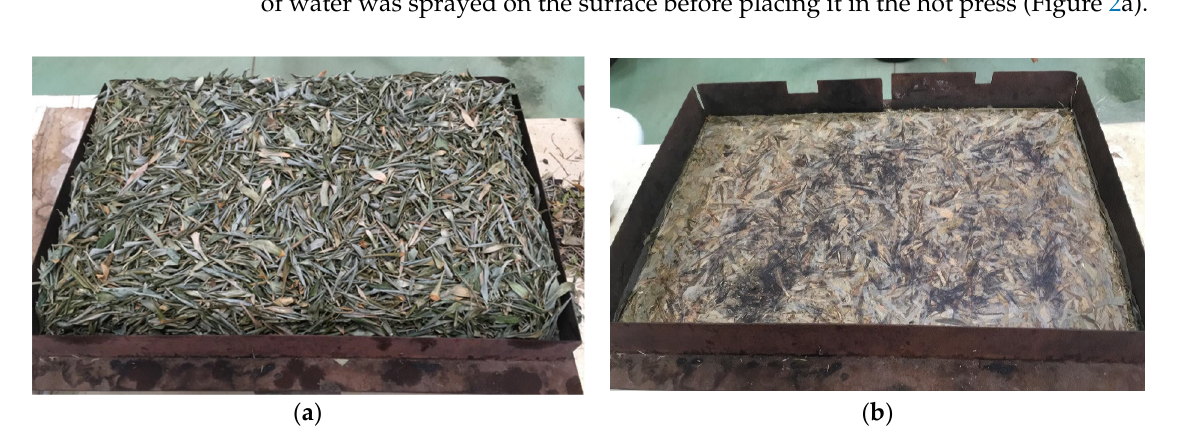
Figure 2. ( a ) Material in the mold; ( b ) panel manufactured in the hot press.